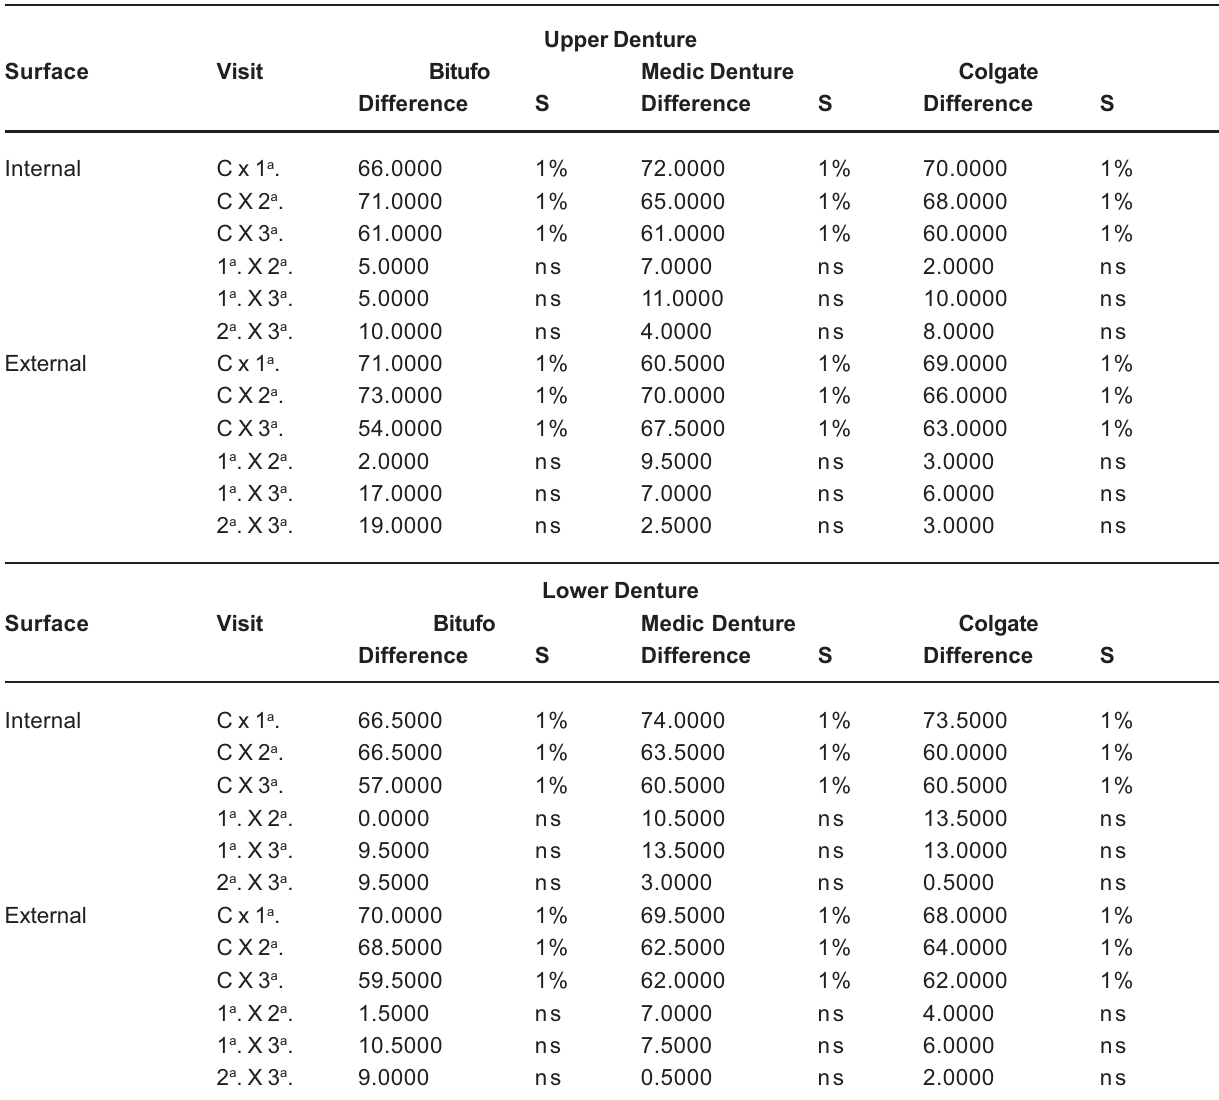
C = control; Difference = difference between post addition; S = significance. ns =